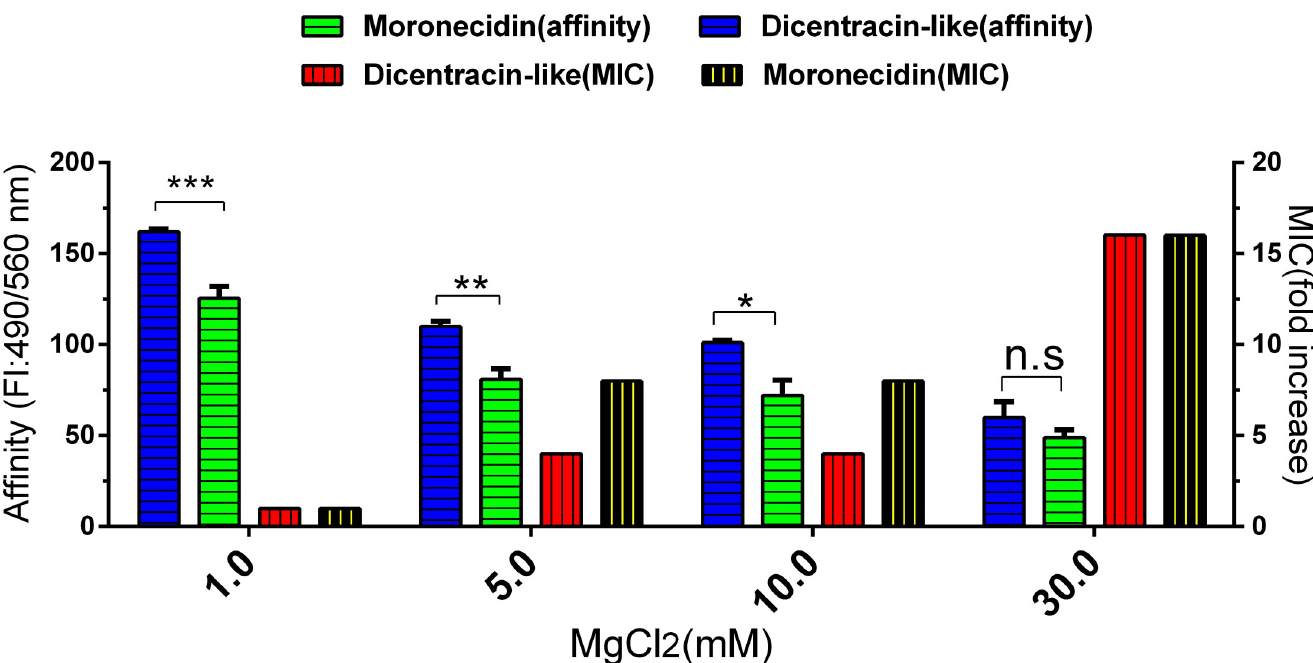
Fig 3. Evaluation of various MgCl2 concentration on the MIC and AMPs binding to bacteria. Binding affinity of moronecidin and dicentracin-like to bacteria (E. coli) were measured with a cell-based fluorometric ELISA. Fluorescence intensity (FI) of wells were measured in various MgCl 2 concentrations (1, 5, 10 and 30 mM) on a microplate reader at excitation /emission (Ex/Em) = 490/560 nm. Fold increase scores in MIC were calculated by MIC (MgCl2) /MIC. The scores represent three independent experiments. � P � 0.05, �� P � 0.02, ��� P � 0.01.